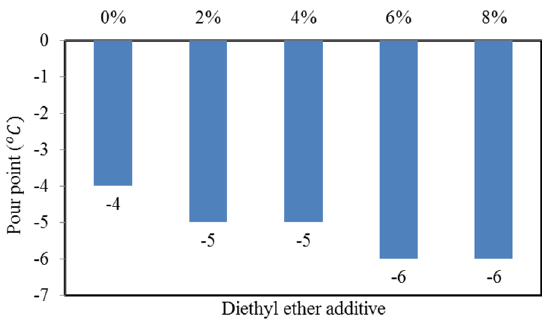
Figure 7. Effect of increasing diethyl ether percentage on blended B30 fuel pour point.